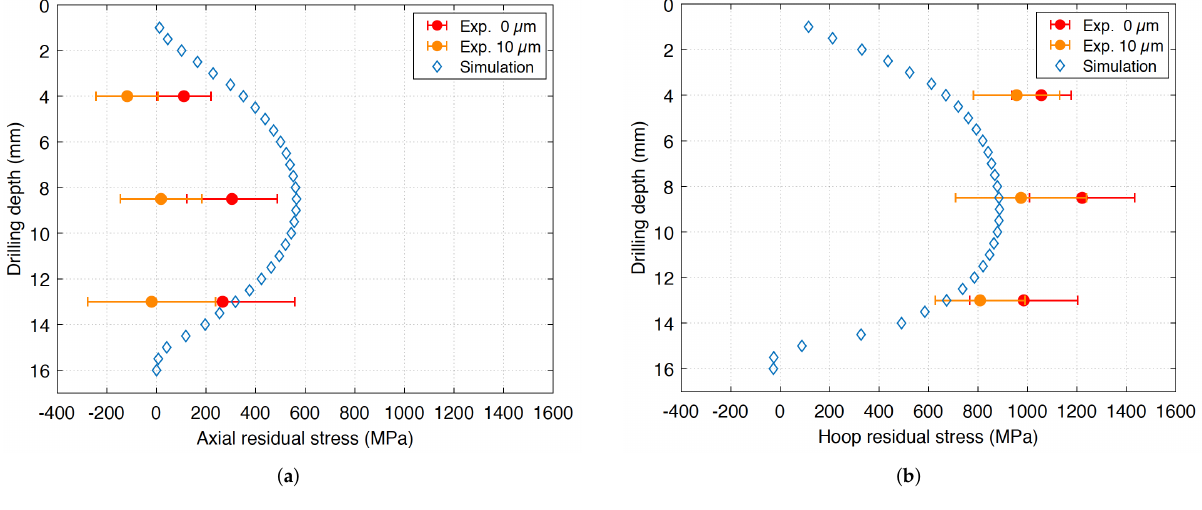
Figure 19. Comparison between experimental and numerical results: ( a ) axial residual stress; and ( b ) hoop residual